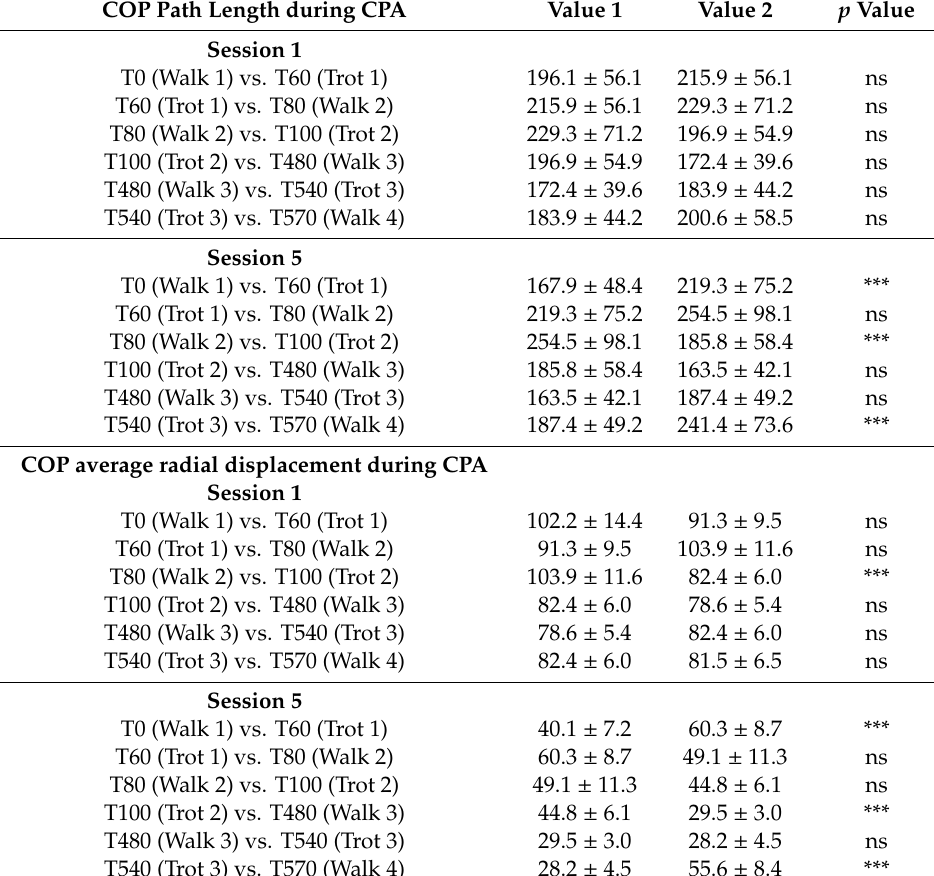
Table 2. Comparison of intrasession COP path length and COP average radial displacement during compensatory postural adjustment (CPA) when pace changes (3 second intervals). Values correspond to means ± SD of the mean. p < 0.001